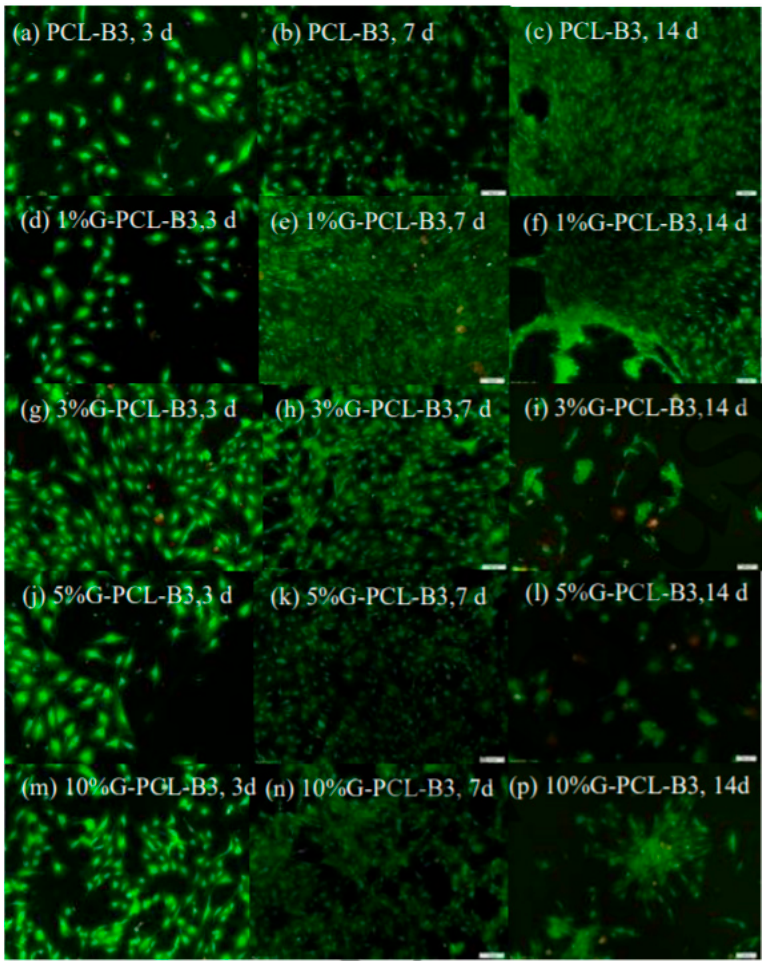
Figure 4. Live (green) and dead (red) MC3T3-E1 cells seeded on poly ε -caprolactone (PCL)-coated bioactive glass with different percentages of graphene. ( a – c ) Without graphene, ( d – f ) 1 wt.% graphene (G), ( g – i ) 3 wt.% G, ( j – l ) 5 wt.% G and ( m – p ) 10 wt.% G. After 7 days, the density of cells on G-containing